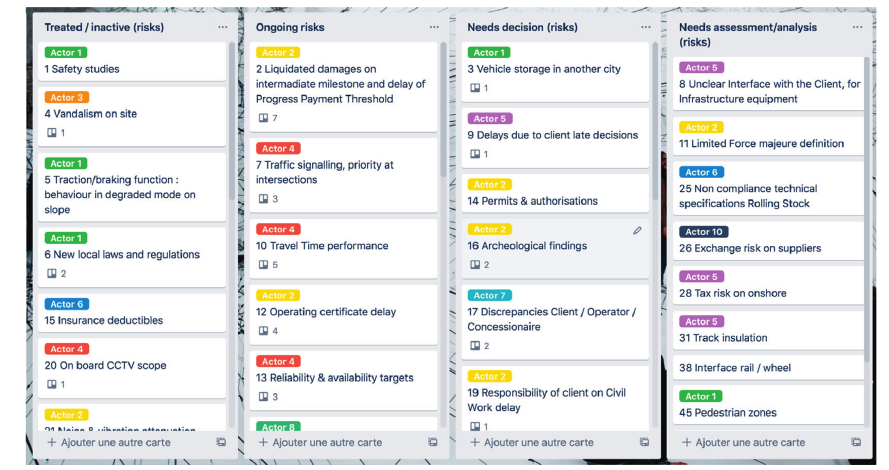
Figure 12: Example of a Risk Kanban tool, showing the different states of risks throughout their